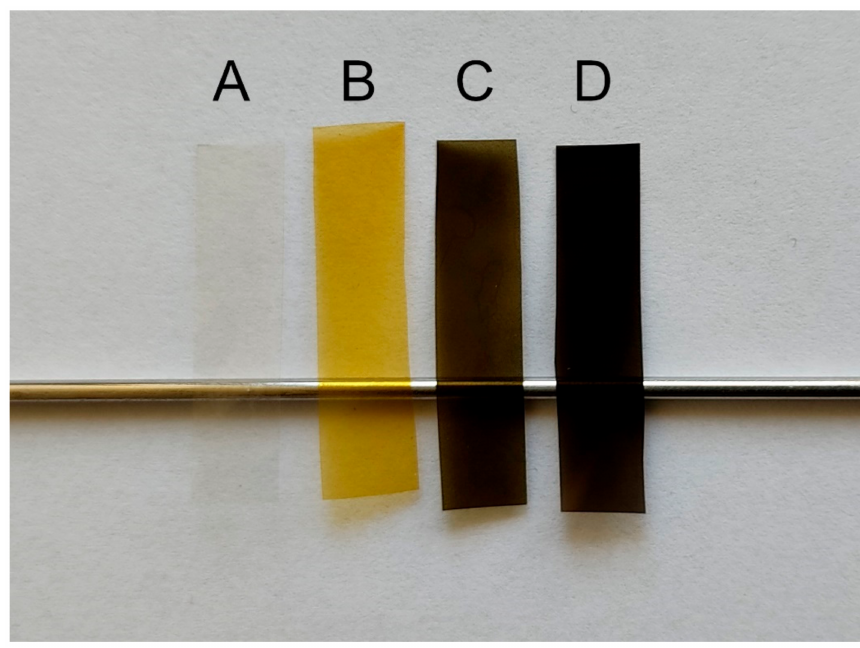
Figure 1. Obtained foils: A—Hyal/C; B—Hyal/Ag; C—Hyal/Ag/GO;